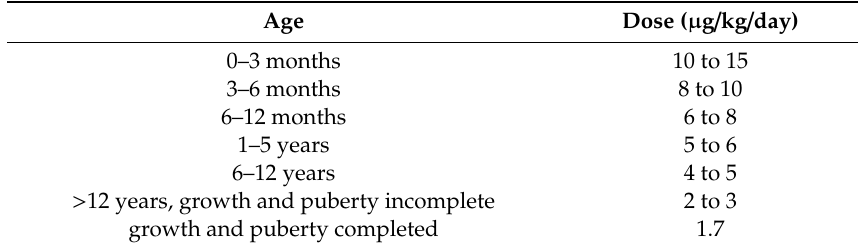
Table 2. Levothyroxine dosing guidelines in newborns, infants, and children for pediatric hypothyroidism. Doses should be individualized to patient response based on clinical response and laboratory parameters (thyrotropin-stimulating hormone (TSH),